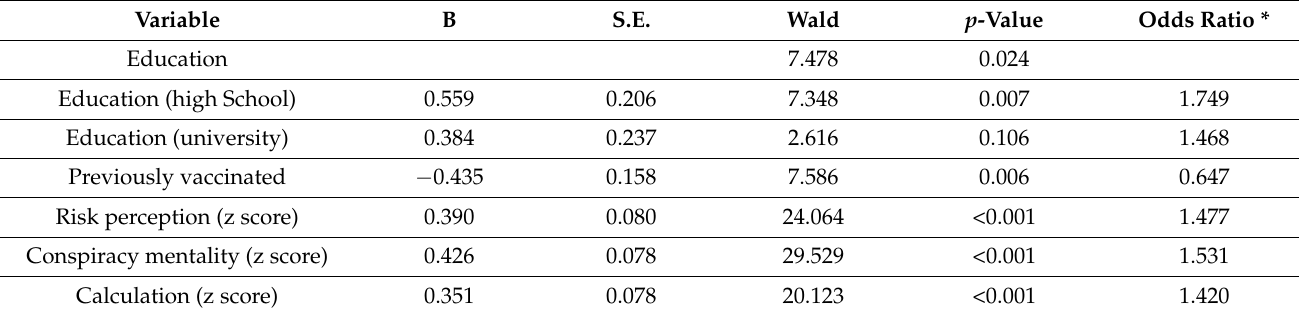
Table 3. Results from the logistic model after the second block was